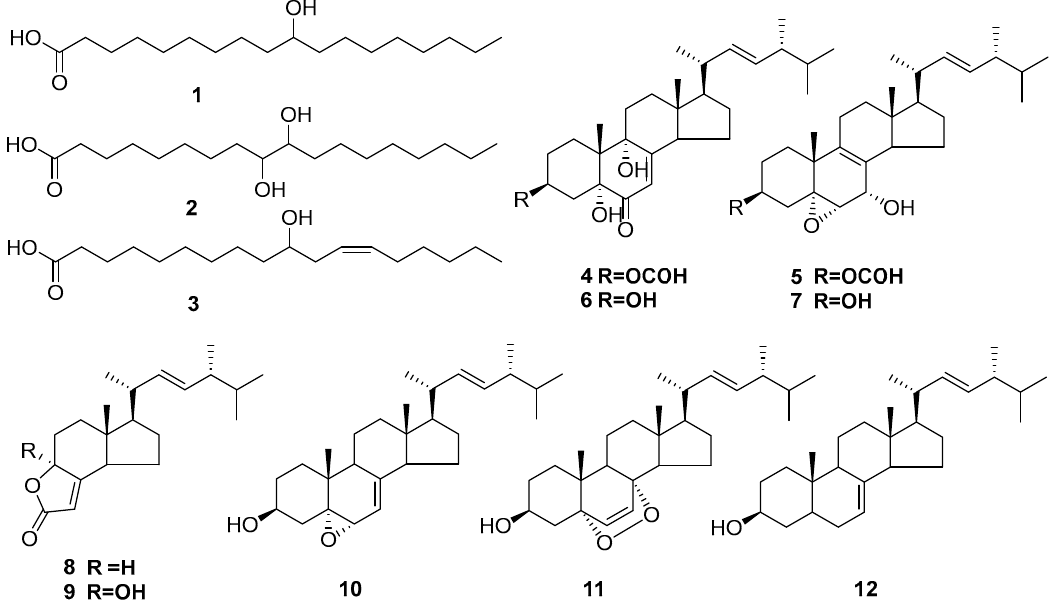
Figure 6. The structures were identified from P. lavendulum .